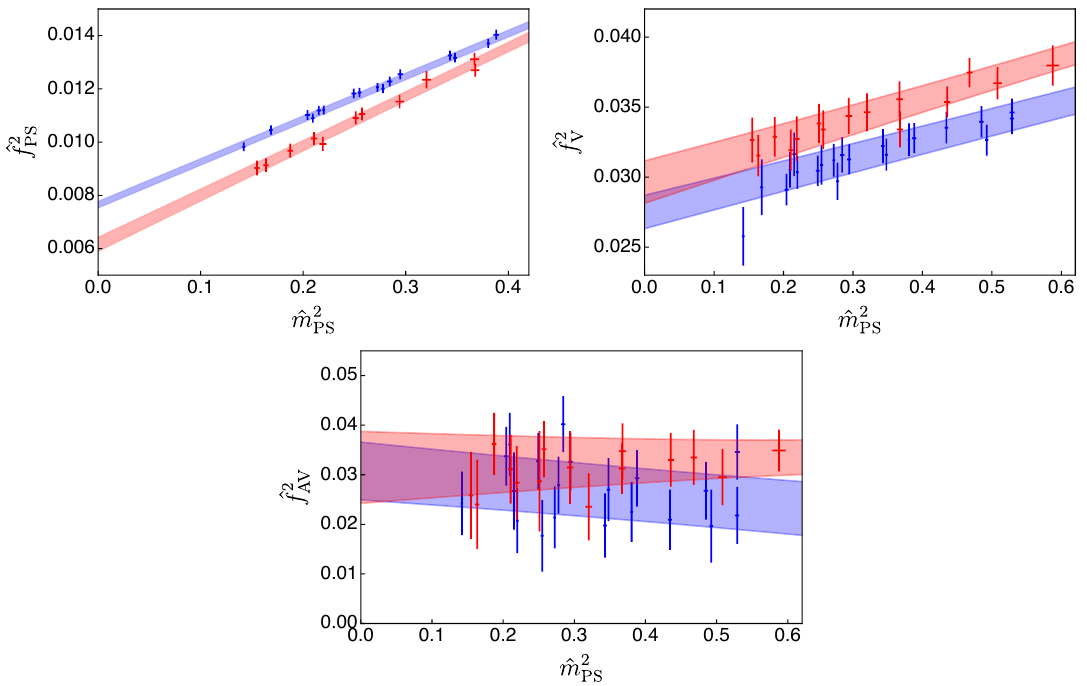
Figure 19. Meson decay constants squared from quenched (blue) and dynamical (red) calculations, in the continuum limit obtained by considering all the ensembles with ^ m 2 . 0 : 4 for ^ f 2 but restricting to ^ m 2 , as in section 4.3. The coloured bands illustrate the (cid:12)t of the PS PS measurements used in the massless extrapolations, with the width of the bands representing the statistical error in the